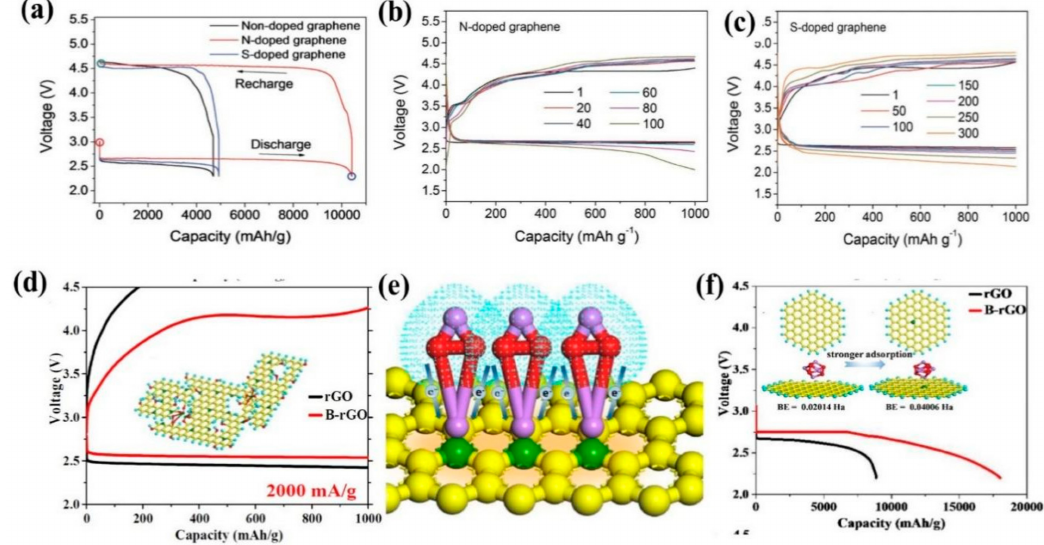
Figure 6. ( a ) Constant current discharge charge distribution of lithium oxygen battery with nanoporous graphene cathode at 200 mA g − 1 current density, ( b , c ) Charge–discharge cycling